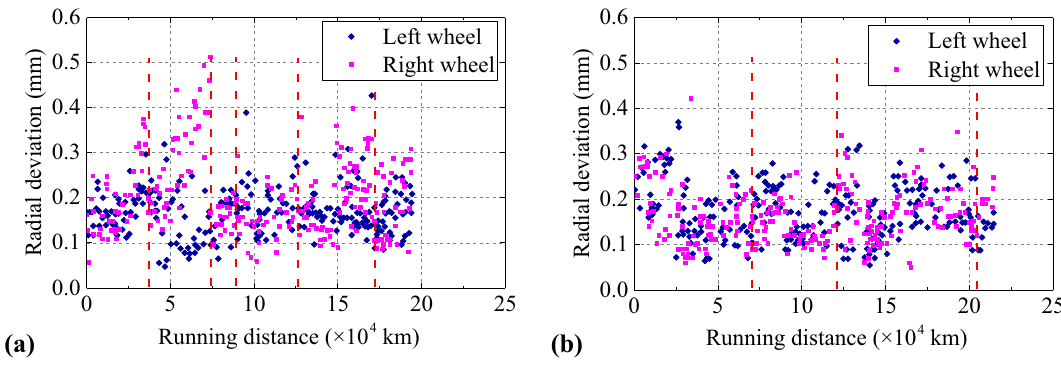
Fig. 23 Development of wheel OOR [117] for a ER7 and b C64M wheels. Dashed lines indicate